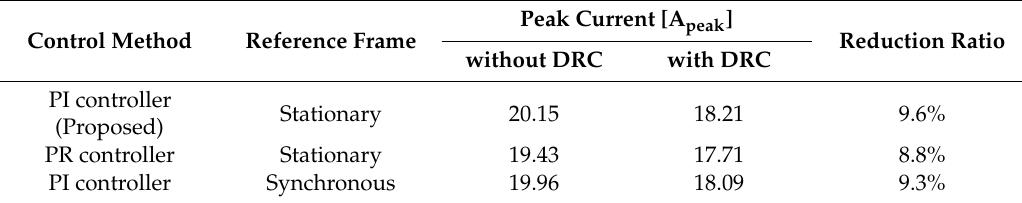
Table 4. Summary of simulation results at grid fault in Figure 8.